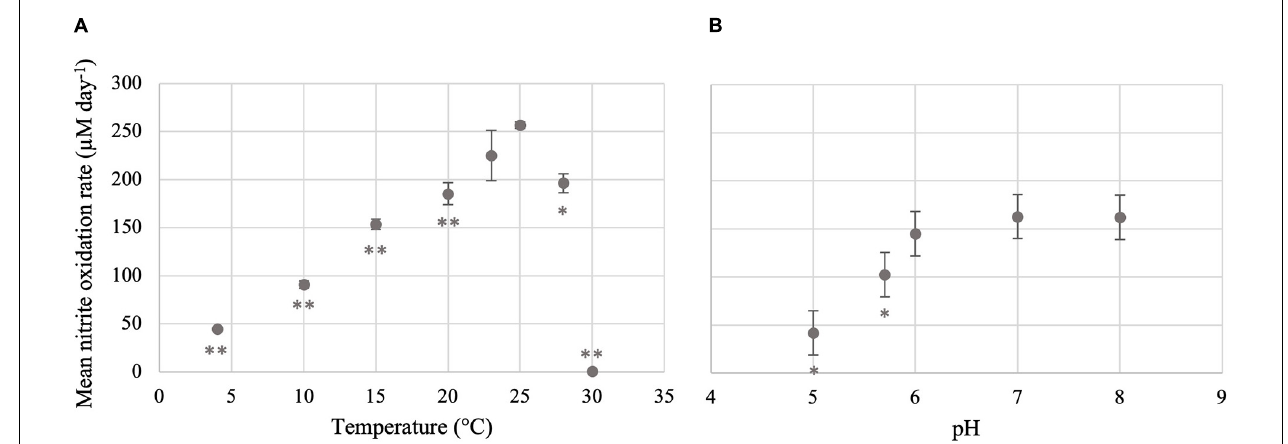
FIGURE 3 | Temperature and pH optima for the nitrite-oxidizing activity of Ca . Nitrotoga sp. CP45. (A) Mean nitrite oxidation rates during incubation at varying temperatures. (B) Mean nitrite oxidation rates during incubation at varying pH conditions. Values are means of triplicate biological replicates with ± standard deviations (error bars). If not visible, error bars are smaller than data points. Values that are significantly different from the optima (highest rate; 25 ◦ C for temperature and pH 7 for pH) by t -test are indicated by asterisks as follows: * p < 0.05; ** p <